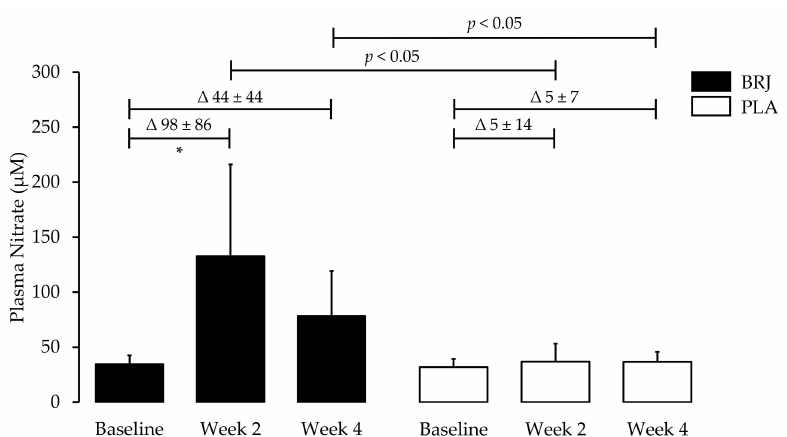
Figure 2. The e ff ects of four weeks of BRJ consumption or PLA on plasma nitrate. Beetroot juice consumption increases plasma nitrate in healthy older adults. Data are expressed as mean ± SD. * Significance shown for comparisons within treatment allocations of the change between baseline, week 2 and week 4, p < 0.05 for Bonferroni post hoc test. Significance shown for comparisons between